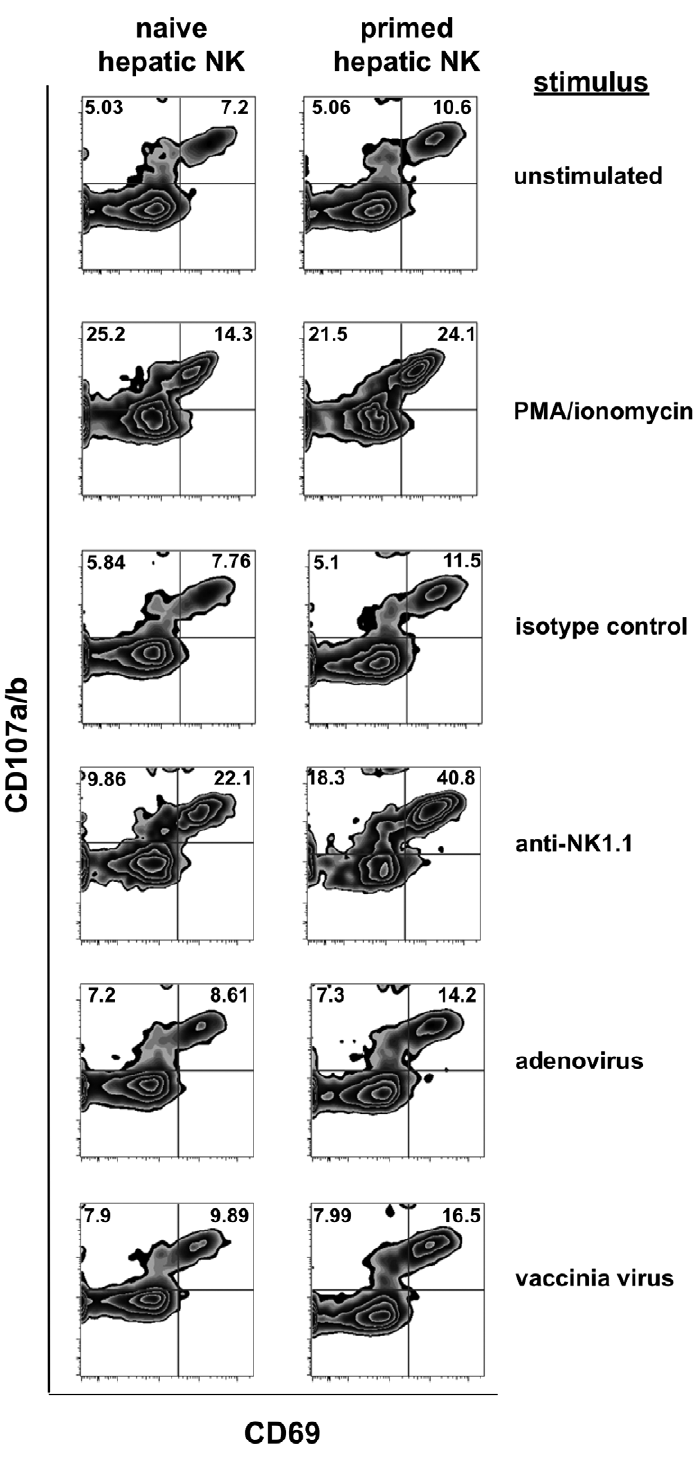
Figure 3. Intracellular cytokine staining of previously primed NK cells demonstrates enhanced activation following in vitro stimulation. Lymphocytes and NK cells isolated from collagenase-dissociated liver preparations from naı¨ve and vaccinia virus-infected mice were cultured in vitro with the indicated stimuli for 6 hours prior to evaluation for NK cell activation (expression of CD69) and degranulation (expression of CD107) in response to the stimulation. Stimuli include plate-bound isotype control Ig, the anti-NK1.1 monoclonal antibody PK-136, formaldehyde-fixed adenovirus (2 6 10 6 vp), and formaldehyde-fixed vaccinia virus (2 6 10 6 pfu). Plots shown are gated on NK cells (NK1.1 + CD3 2 or DX5 + CD3 2 ).